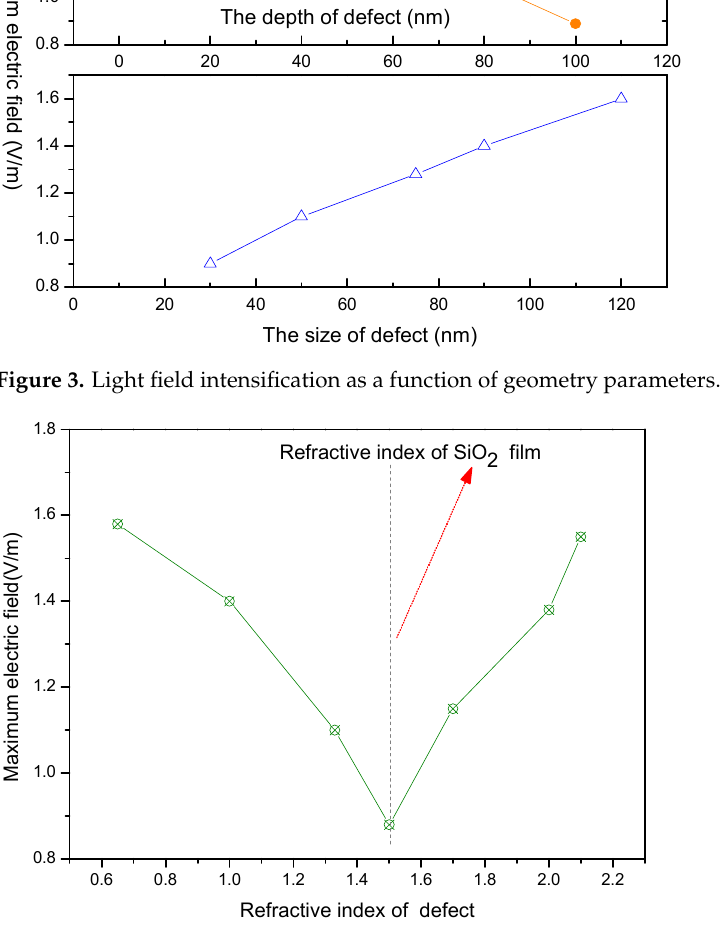
Figure 4. Light field intensification as a function of refractive index of the defect.